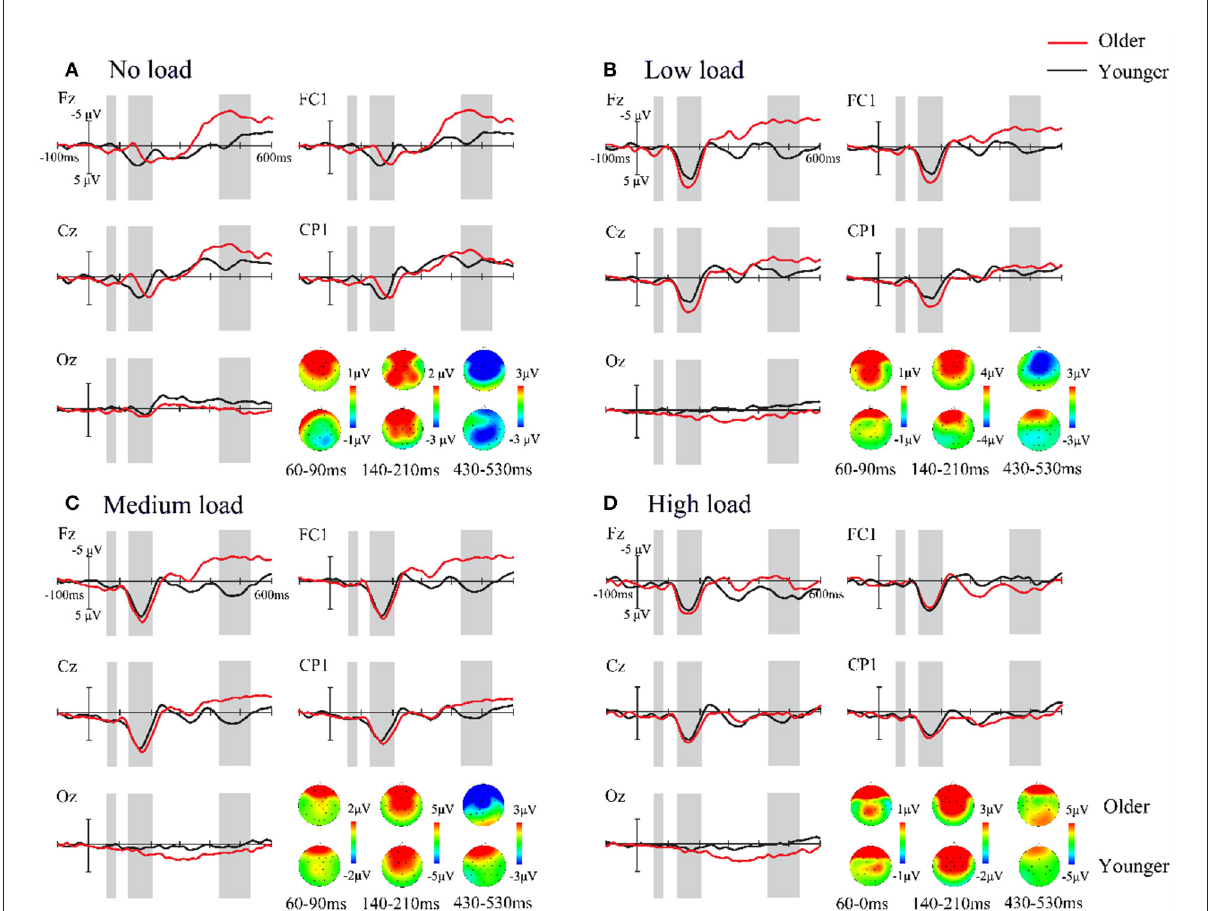
FIGURE4 (A–D) Grand-average event-related potentials and topography maps in the four attentional load conditions. The difference wave, ERP [AV – (A + V)], is shown from 100ms before to 600ms after stimulus onset in the older (red) and younger (black) adults with the five ROIs, which shows the age difference in audiovisual integration processes. Time courses with significantly marked with a gray background. One representative electrode is shown separately per